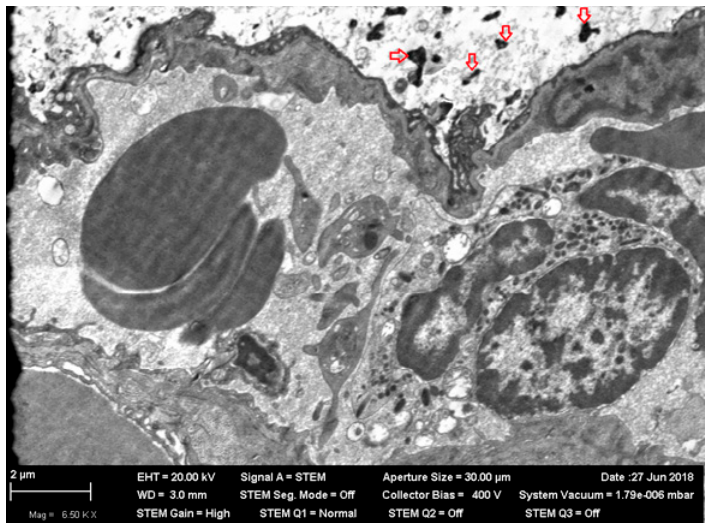
Figure 5. Rat lungs after 3 months of inhalation exposure to NiO-NPs at a concentration of 0.23 mg / m 3 . STEM; magnification: 6500 × . Nanoparticle aggregates in the alveolar space are noted with arrows.